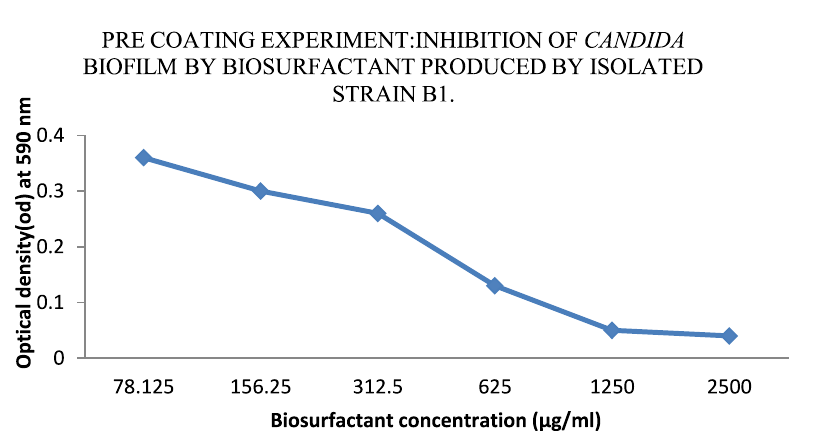
Fig. 2. Effect of various concentrations of biosurfactant on C. albicans biofilms in the presence of biosurfactant (precoated on the wells of a microtiter